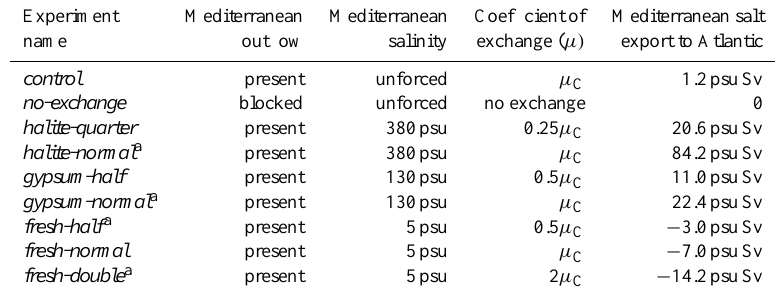
Table 1. Summary of the differences between all simulations. For Messinian control and no-exchange , Mediterranean salinity was left unforced, resulting in normal, open marine salinity conditions of ∼ 44psu for the basin.